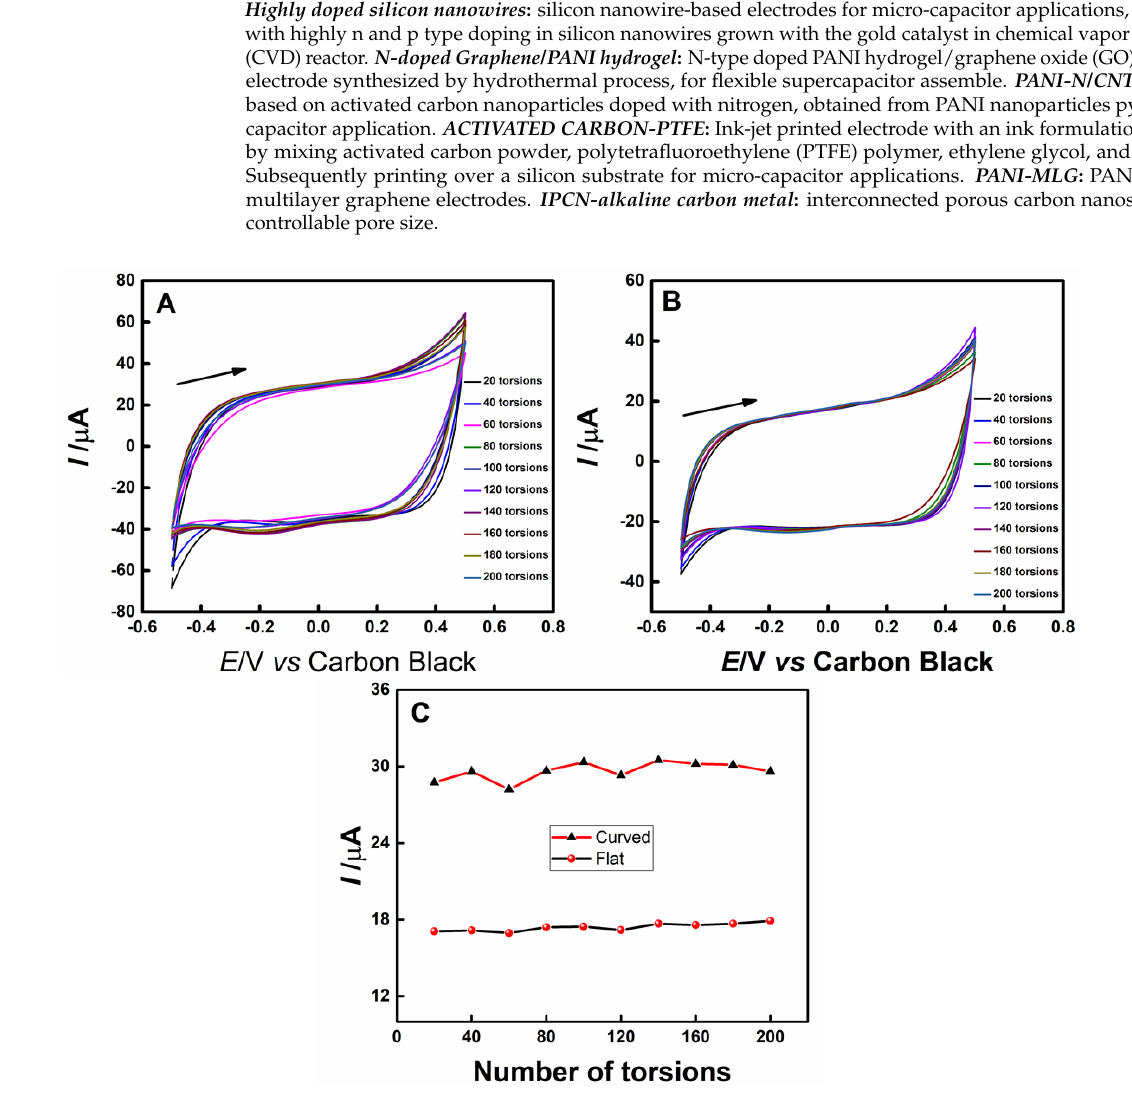
Figure 6. Cyclic voltammograms of the flexibility study on the ( A ) curved device and ( B ) flat device, in 1.0 mol L − 1 H 2 SO 4 ; ν = 50 mV s − 1 . ( C ) I vs. the number of torsions dispersion plots for ( ▲ ) curved and ( ● ) flat electrodes. Data was collected at 0.0 V.